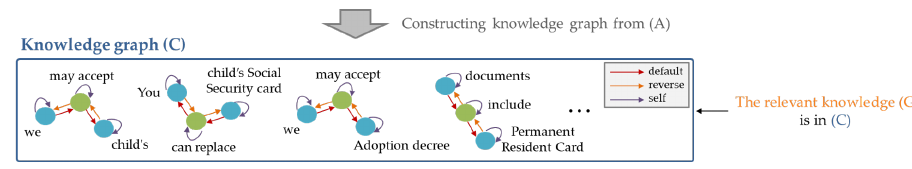
Figure 3. Process of constructing knowledge graph from the relevant document